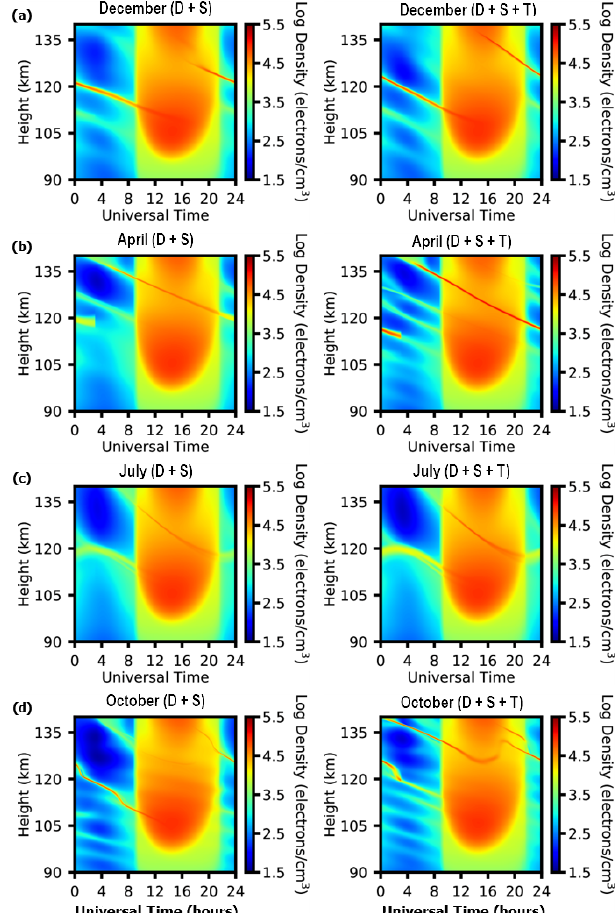
Figure 7. Density profiles of the E s layers simulated by MIRE dur- ing (a) December (summer), (b) April (autumn), (c) July (winter), and (d) October